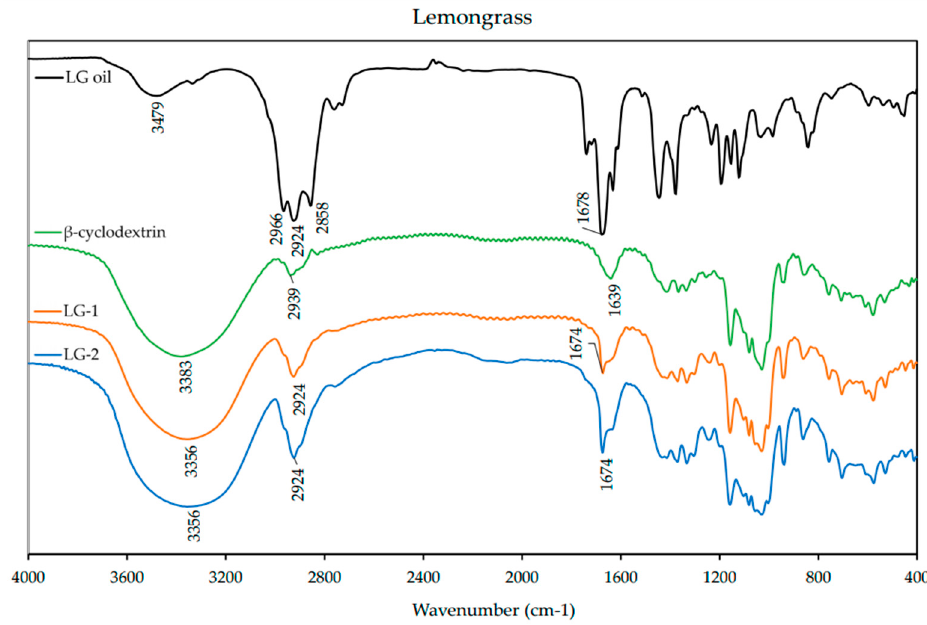
Figure 4. FT-IR spectra of lemongrass (LG) essential oil, β -cyclodextrin, and inclusion complexes LG-1 and LG-2. Spectra were obtained from 400–4000 cm − 1 with a resolution of 3.857 cm − 1 as an average of 32 scans on a FT-IR spectrophotometer.